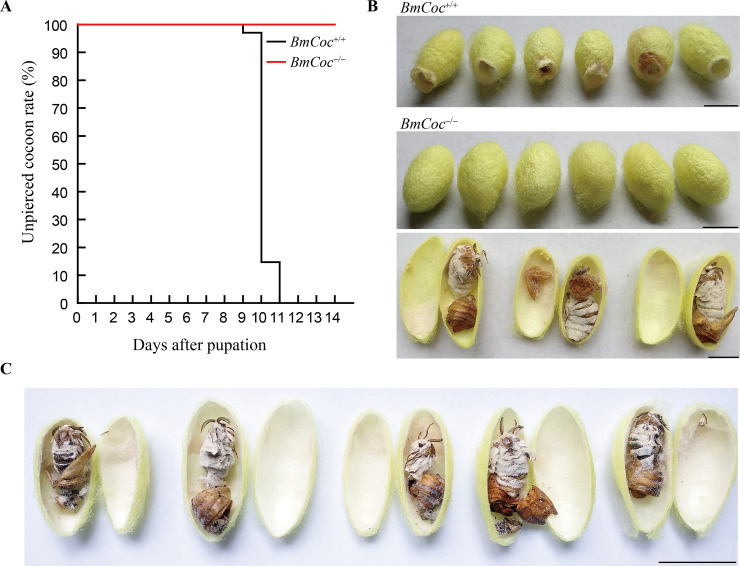
Effects of knocking out BmCoc on moth eclosion and emergence.(A) Unpierced cocoon rate of BmCoc+/+ and BmCoc-/- individuals. One hundred individuals of wild type and BmCoc-/- homozygotes were randomly selected for analysis. (B) Morphological observations of BmCoc+/+ and BmCoc-/- cocoons. BmCoc+/+ cocoons with pierced holes caused by the moth escaping from the cocoon are shown on the top image. Intact cocoons of BmCoc-/- and split cocoons with a successfully metamorphosed moth inside are shown below. Bar = 1 cm. (C) Morphological observations of homozygotes naturally stored for more than six months. Inside the cocoons are dried moths that have died naturally. Bar = 2 cm.